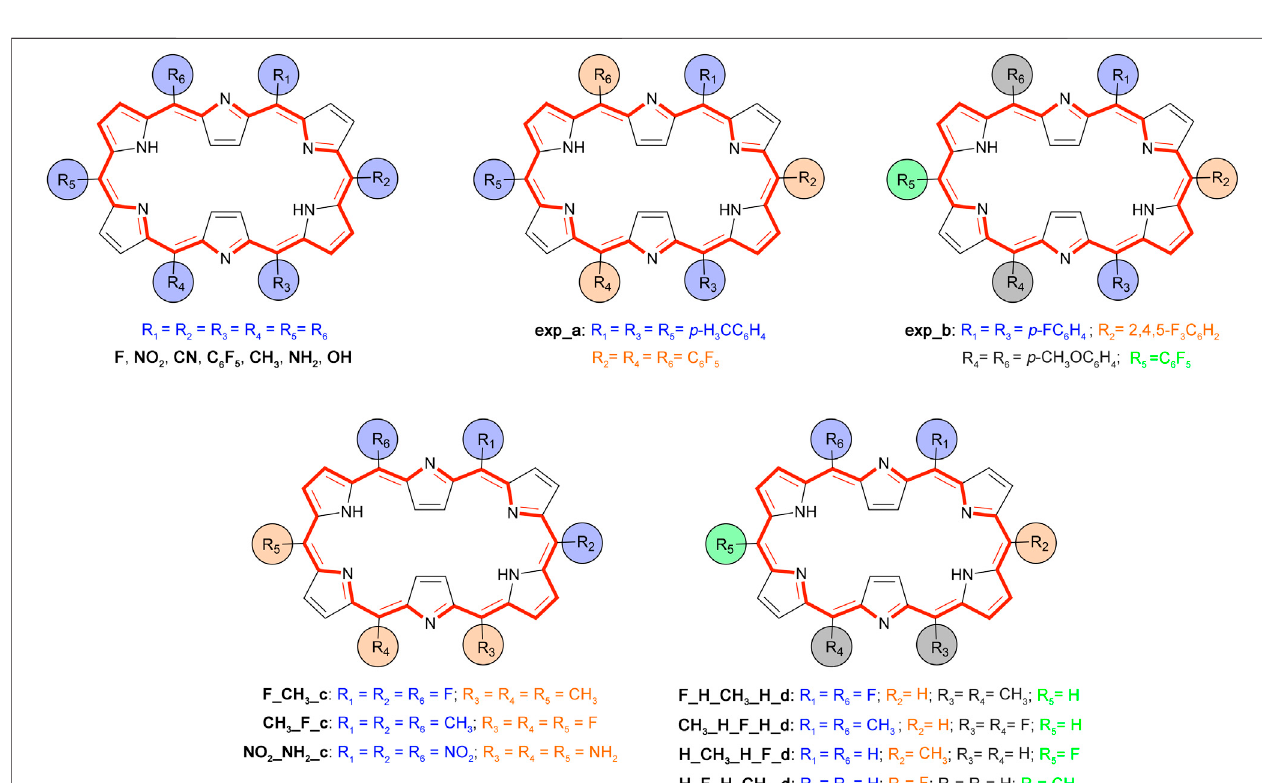
SCHEME 3 | Overview and labelling of the meso -substituted structures based on the 26R topology.